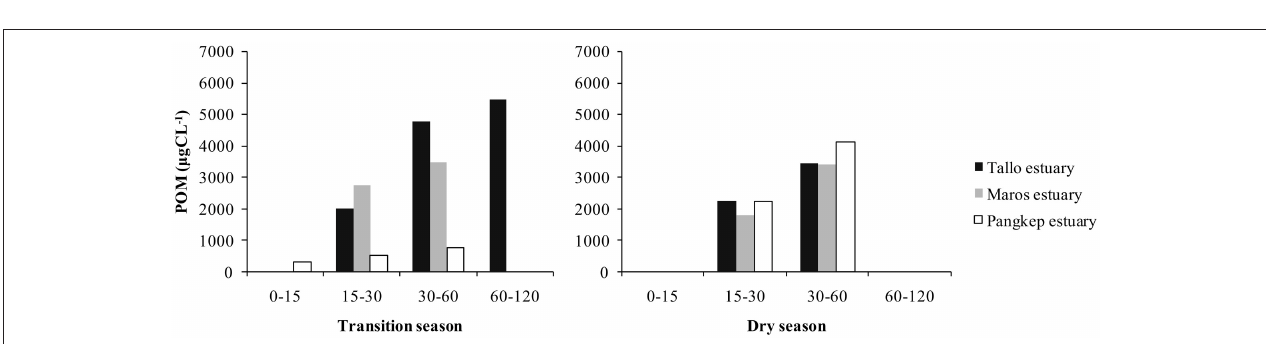
FIGURE 4 | Increased particulate organic matter (POM, µ gCL − 1 ) in the concentration range of suspended particulate (SPM) on the west coast of South Sulawesi. Transition Season (April 2013); Dry Season (June